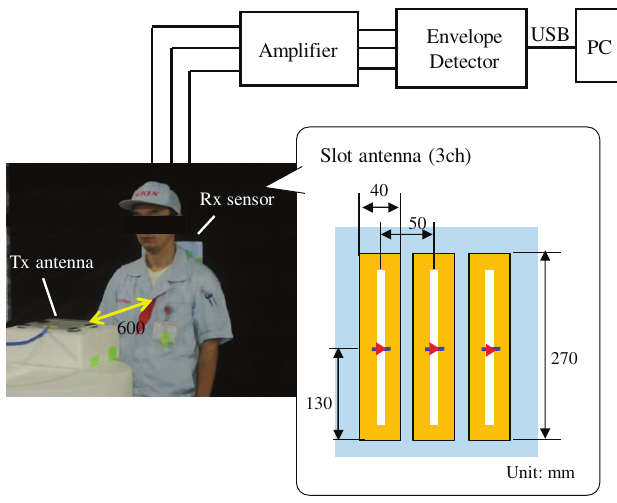
Figure 12. Experimental setup and receiving sensor